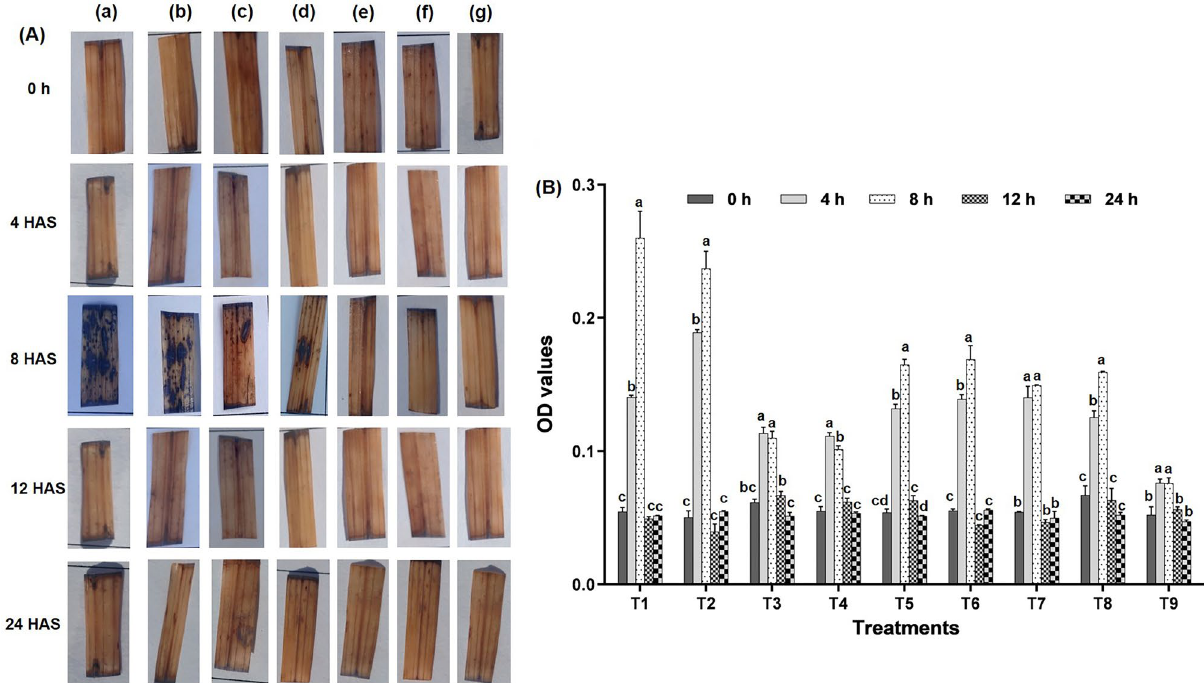
Figure 4. Effect of fungicides on production of super oxide radicals ( A ) In vivo localisation of super oxide radicals at different interval in response to fungicidal stress (a) T 1 : tricyclazole, (b) T 2 : carbendazim, (c) T 5 : tricyclazole + LBS6, (d) T 6 : tricyclazole + LBD1, (e) T 7 : carbendazim + LBS6, (f) T 8 : carbendazim + LBD1, (g) T